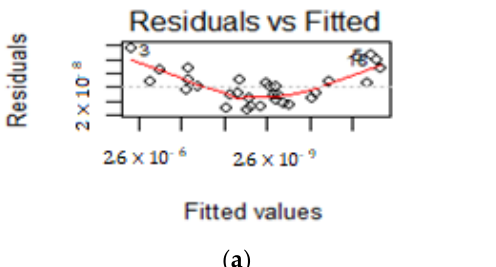
Figure 4. Residual analysis for the model with all the inputs: case 3.2.1—Thinner core. ( a ) Residual vs. fitted values; ( b ) Normal QQ plot.